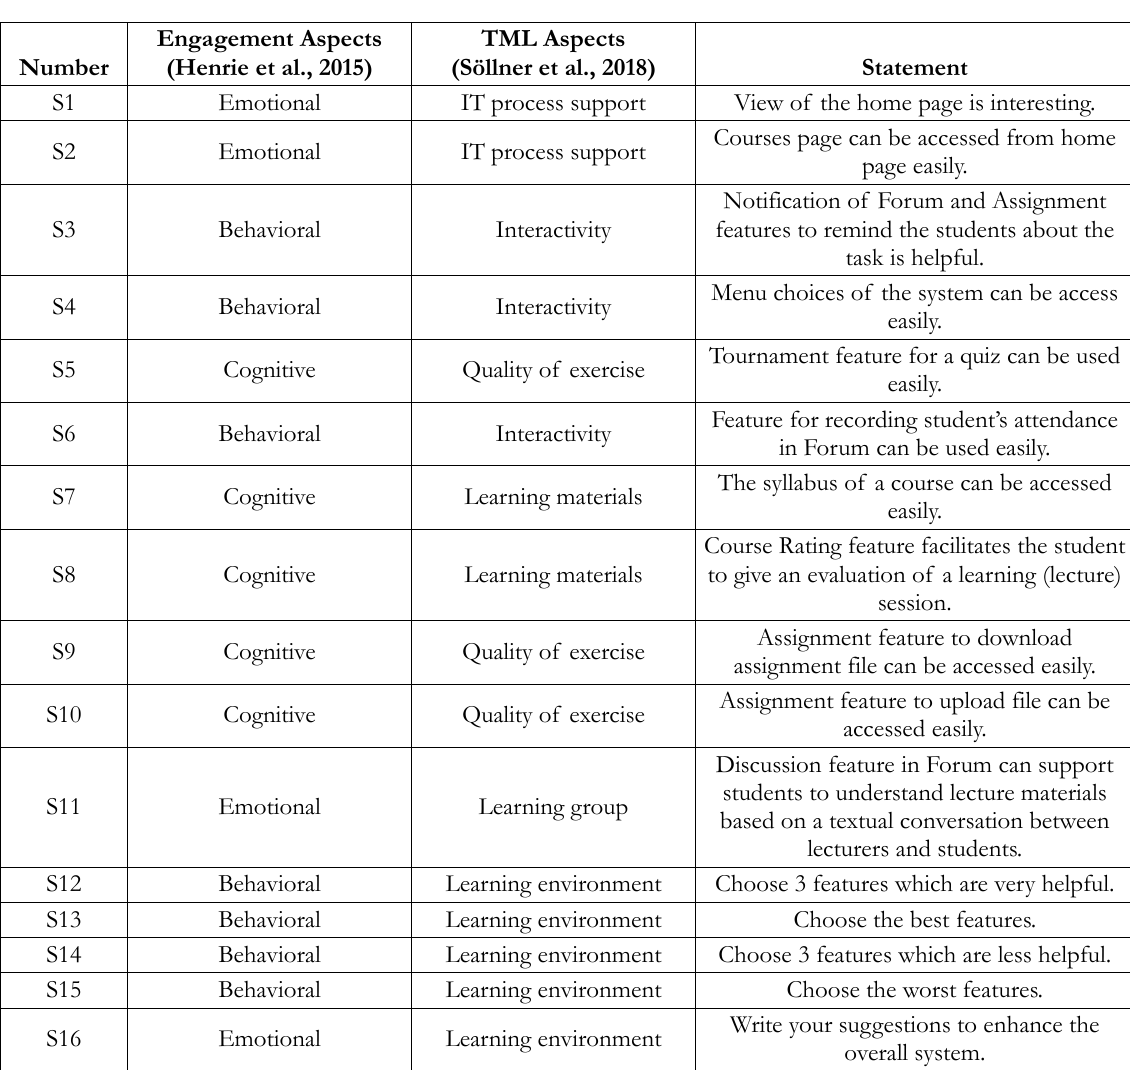
Table 2. Questionnaires of the evaluation